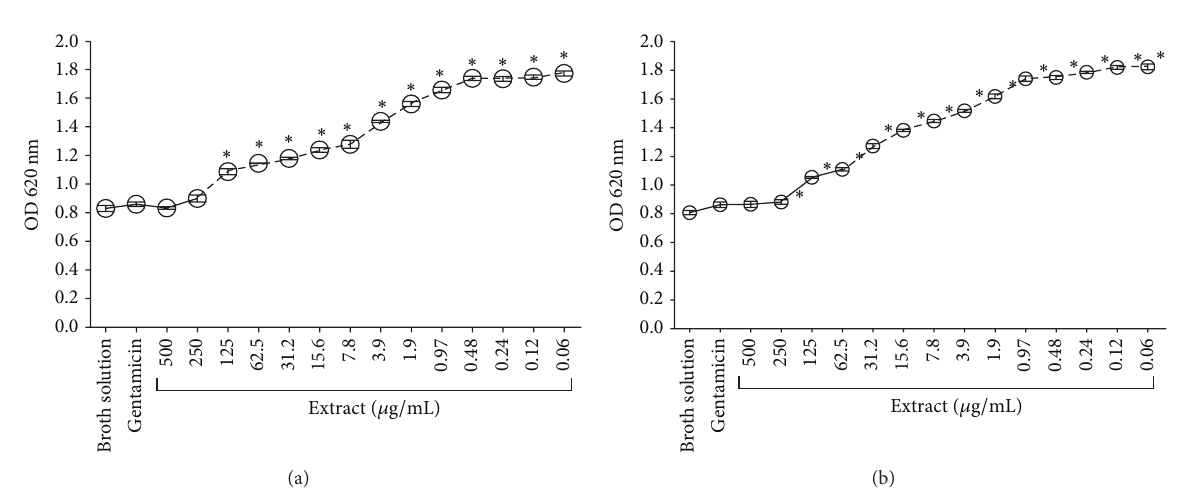
Figure 3: MIC of the oily and ethanolic phases from Mammea americana extract against Porphyromonas gingivalis . (a) The MIC of the oily phase was 250 𝜇 g/mL, (b) while the MIC of the ethanolic phase was 500 𝜇 g/mL. Each symbol represents the mean ± SEM for each concentration tested ( 𝑛 = 4 per ( 𝜇 g/mL)). 𝑃 value < 0.05: ( ∗ ); Kruskal-Wallis test and Dunnett’s